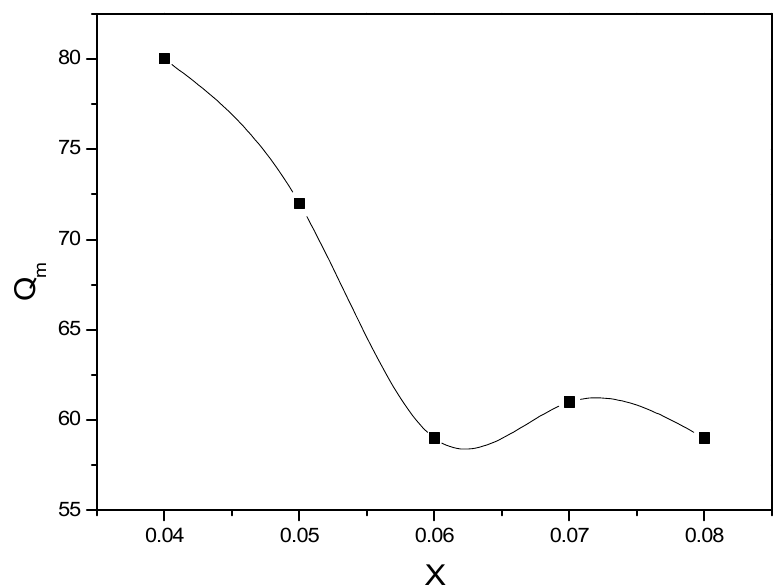
Figure 6. Mechanical quality factor (Qm) of samples with the amount of antimony. The dielectric constant ε r and piezoelectric constant d 33 of samples with the antimony are shown in Figures 7 and 8, respectively. The dielectric constant ε r of samples with the antimony increased linearly. After poling the samples as a 3 kV/mm electric field (E), the d 33 was measured. The d 33 was increased with the content of antimony up to x = 0.07 and then reduced above x = 0.07. In general, in order to increase the sound pressure level of the piezoelectric speaker, the highest d 33 is required because the strain (S) is in proportion to the electric field (E). The ceramics with x = 0.07 possessed the best piezoelectricity (d 33 = 330 pC/N, ε r = 2521) for piezoelectric speaker application. These values were shown to be higher than d 33 = 241 pC/N and ε r = 1705 in our recently published paper [21,22]. The antimony content can enhance the sinterability of the samples together with the liquid phase formation of CuO and B 2 O 3 , resulting in enhancement of d 33 and ε r . The d 33 of x = 0.07 specimen with electric field shown in Figure 9.